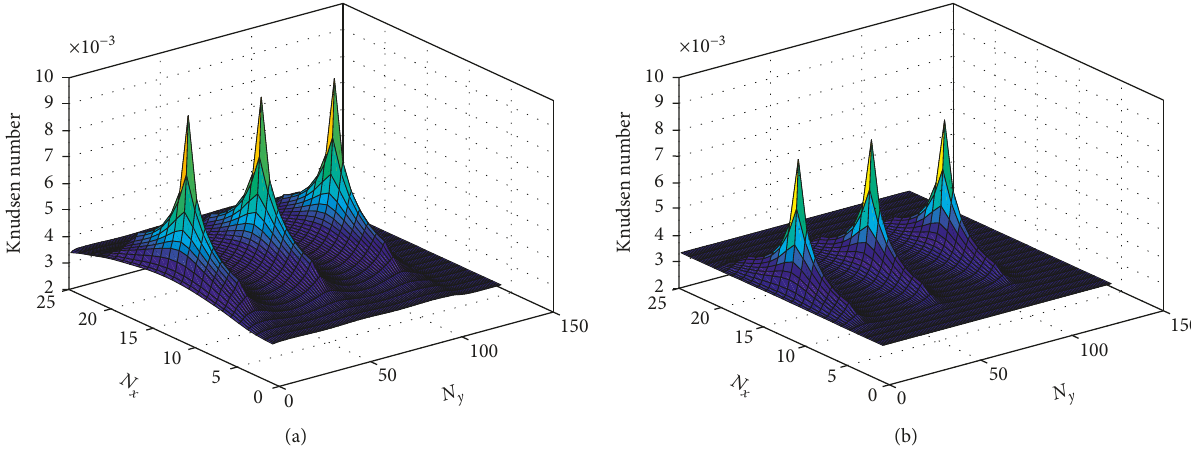
Figure 18: Distribution of Knudsen after 500days with shale porosity equal to (a) 0.01 and (b)